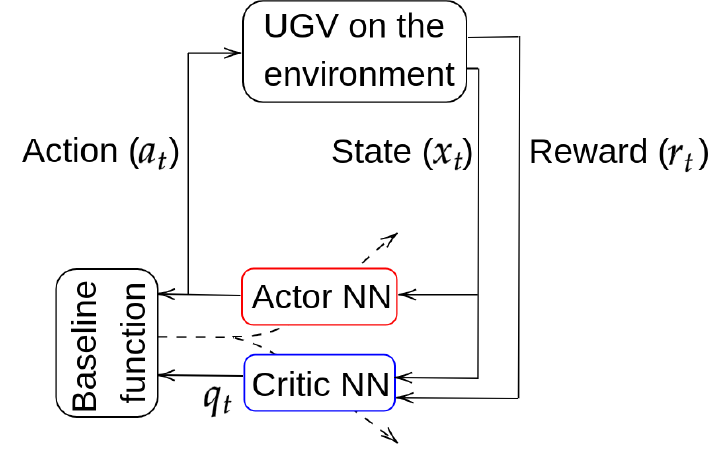
Figure 6. Actor–Critic general